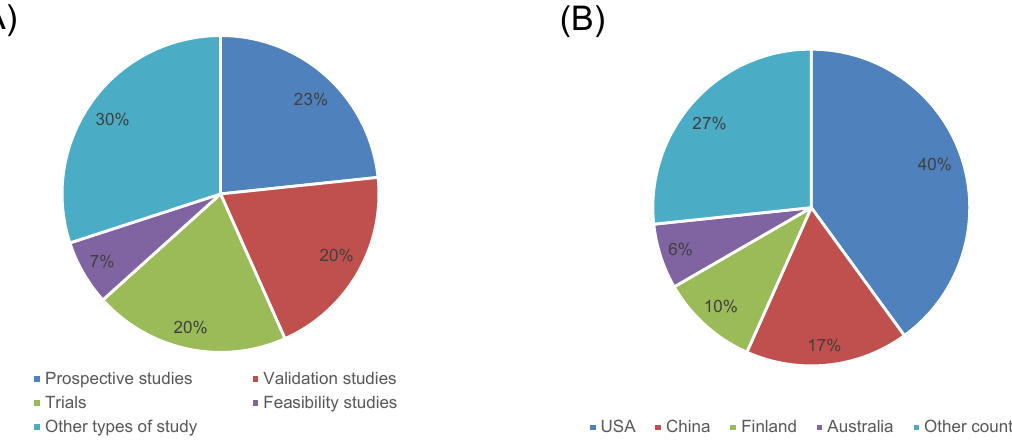
Figure 2. Percentages of studies included in the scoping review ( n = 30) by location ( A ) and study design ( B ).